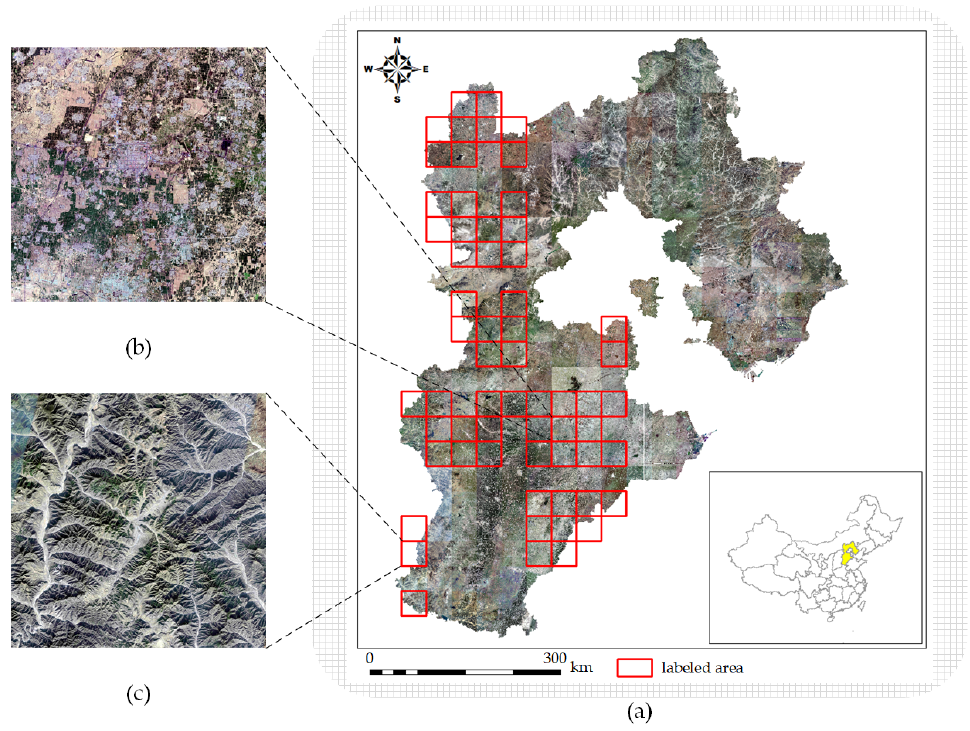
Figure 1. ( a ) Hebei Province and labeled area. ( b ) A remote sensing image from the city area. ( c ) A remote sensing image from Eco-redline